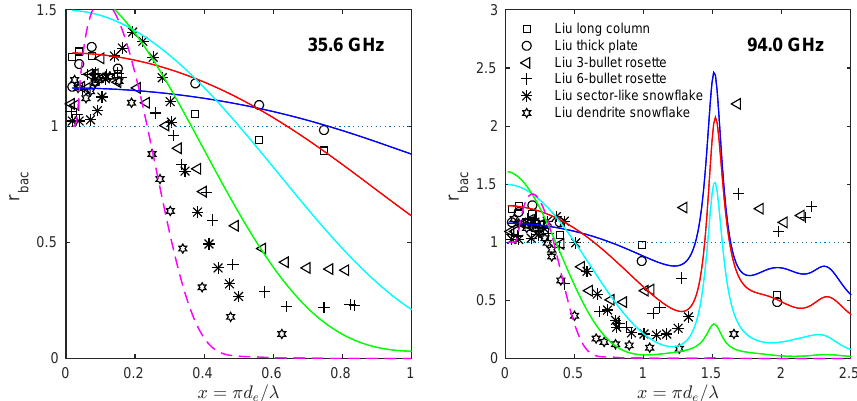
Figure 8. Normalised backscattering of the Liu particles at two frequencies. As in Figs. 4 and 7, the normalisation is performed with respect to the backscattering cross section of the solid sphere having the same mass. For 94GHz and x ≈ 1 . 5 some data points have a ratio above 3 partly due to a minimum of the solid sphere backscattering at that size parameter. Solid and dotted lines are the same as in Fig.